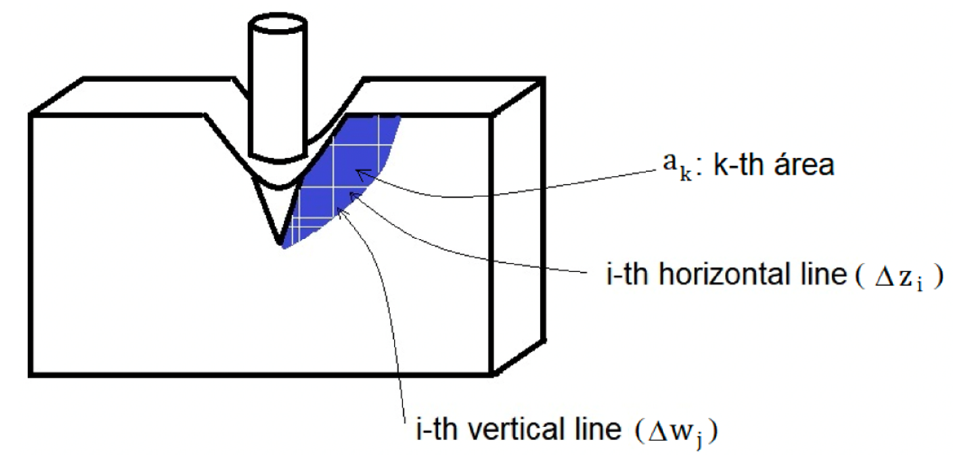
Figure 13. A selected area of a fringe is produced from external stress. The determination of procedures for each fringe or a fringe per image occurs by capturing n horizontal lines and determining their lengths in pixels; after that, the average of the lengths of the horizontal lines and their uncertainty is calculated. Then vertical lines are captured, and their lengths are determined in pixels; the average of the lengths of the vertical lines and their uncertainty are taken into account. Finally, the average area from the product between the average lengths of the horizontal and vertical lines and their uncertainty (Figures 14 and